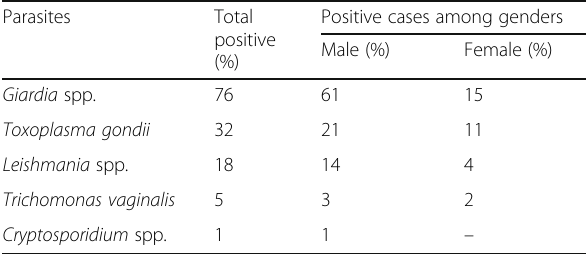
Table 1 The frequency of surveyed parasites among male and female Rattus Parasites Total Positive cases among genders positive Male (%) Female (%)